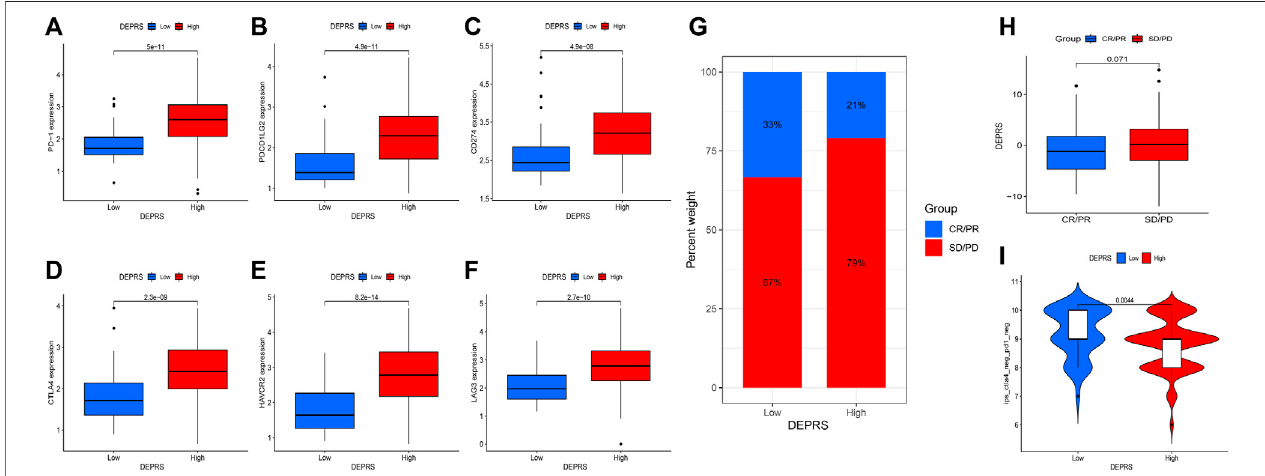
FIGURE 7 | (A – F) Comparison of immunosuppressive checkpoints expression between high DEPRS expression and low DEPRS expression groups. The expression of PD-1 (A) , PDCD1LG2 (B) , CD274 (C) , CTLA4 (D) , HAVCR2 (E) and LAG3 (F) was higher in high DEPRS than in the low DEPRS expression group (all p < 0.05). Statistical comparisons were done using the Wilcoxon test. (G) Proportion of patients with different treatment outcomes in high DEPRS and low DEPRS. The proportion of CR/PR patients in high DEPRS was lower than that in low DEPRS (21 vs 33%). (H) Comparison of DEPRS between different treatment outcome groups ( p = 0.071). (I) The relationship between IPS and DEPRS groups in patients ( p =